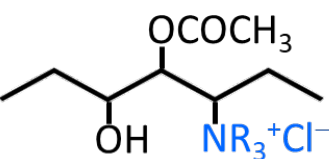
Figure 1. Chemical structure of Gohsenx TM K-434 [48].